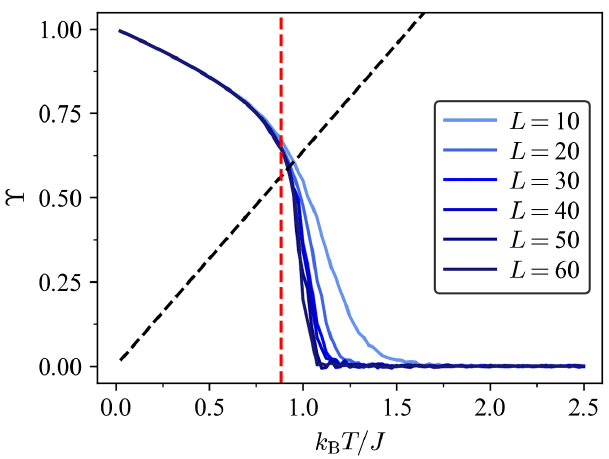
FIG. 17. Helicity modulus ϒ as a function of the tuning T=J for the two-dimensional XY model for parameter p ¼ k B various lattice sizes. The value of the BKT transition point from T =J ≈ 0 . 8935 [92], is highlighted by a red the literature, k B c dashed line. The estimated transition point based on our Monte Carlo samples at finite size corresponds to the point at which the helicity modulus crosses the line given by 2 k (black dashed